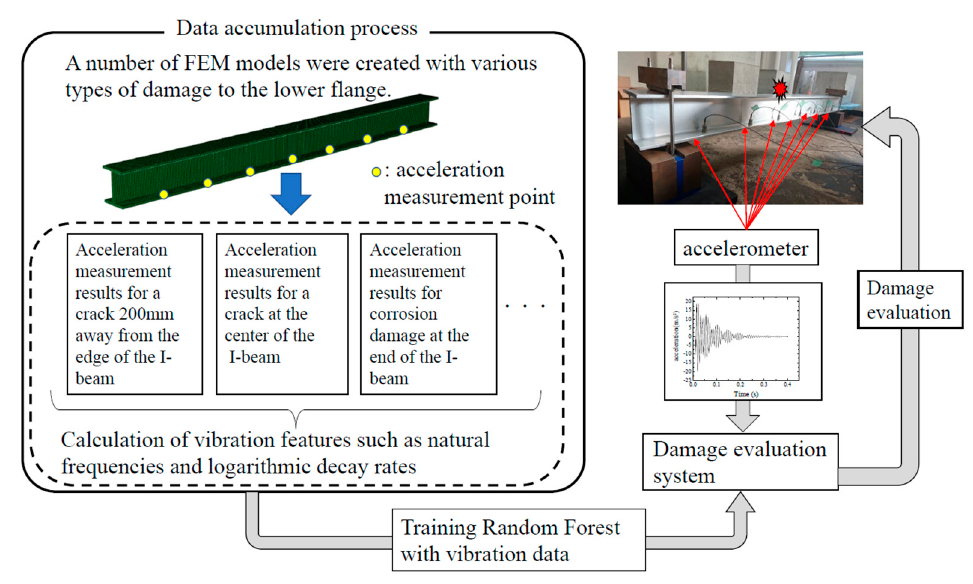
Figure 2. Overview of the methodology of this study.